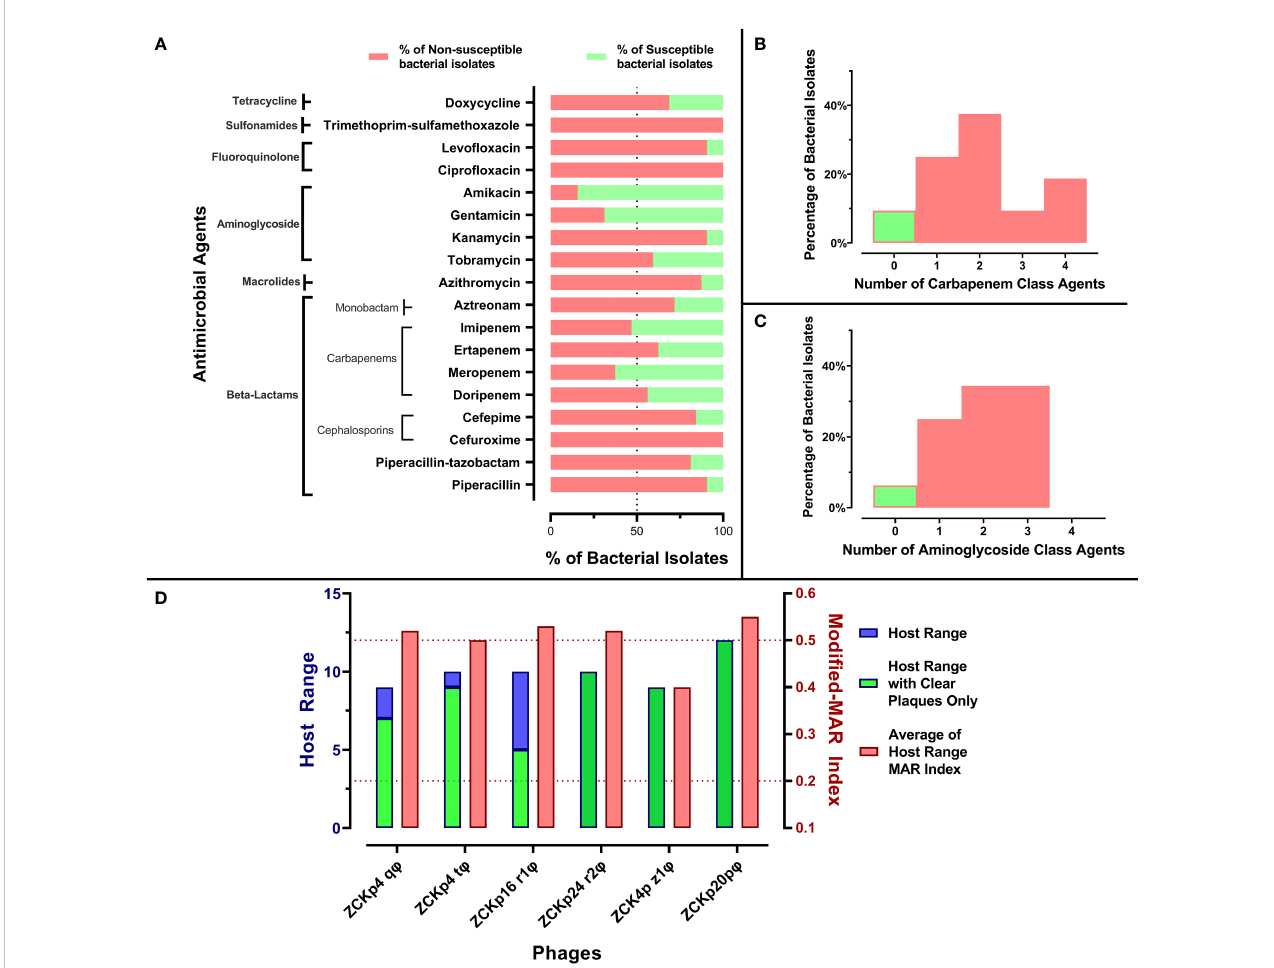
FIGURE 1 Antibiogram of bacterial isolates and phage host range. (A) A stacked-bar chart of bacterial isolates ’ resistance and susceptibility percentages to each tested antimicrobial agent. The susceptibility test was carried out by the disk diffusion method, and the results were interpreted according to CLSI 2019. (B) A histogram representing the percentage of bacterial isolates not susceptible to one or more carbapenem antibiotic. (C) A histogram representing the distribution of bacterial isolates not susceptible to one or more aminoglycoside. (D) Host ranges of the six isolated phages and average modi fi ed-MAR indices of their bacterial hosts. Blue bars represent the number of bacterial isolates in the host range of each isolated phage, while the green bars specify only the number of hosts that showed clear plaques. The left Y-axis describes blue and green bars. Red bars show the average modi fi ed-MAR indices of all isolates included in each isolated phage host range. The scale for red bars is plotted on the right